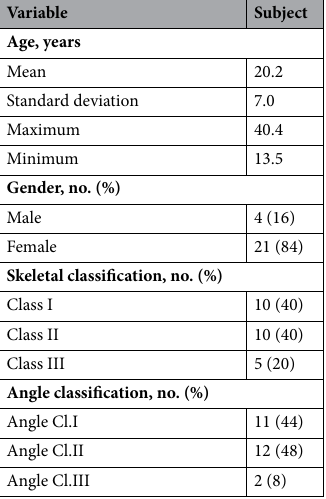
Table 1. Summary of age, gender, skeletal, and Angle classification of